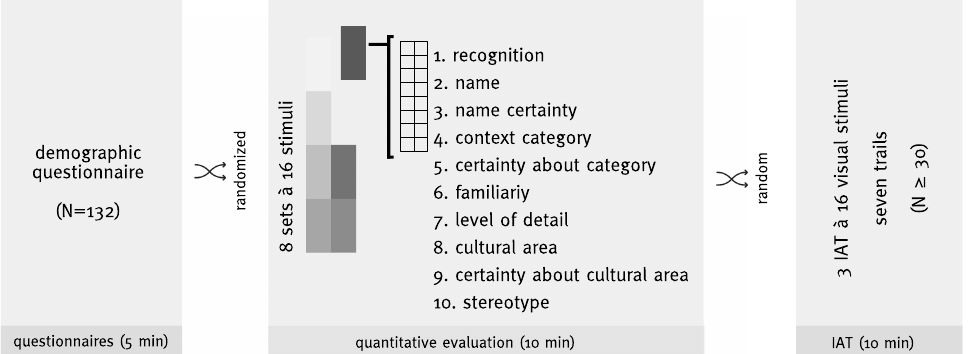
Figure 3. This figure shows the study design and timeline of the second